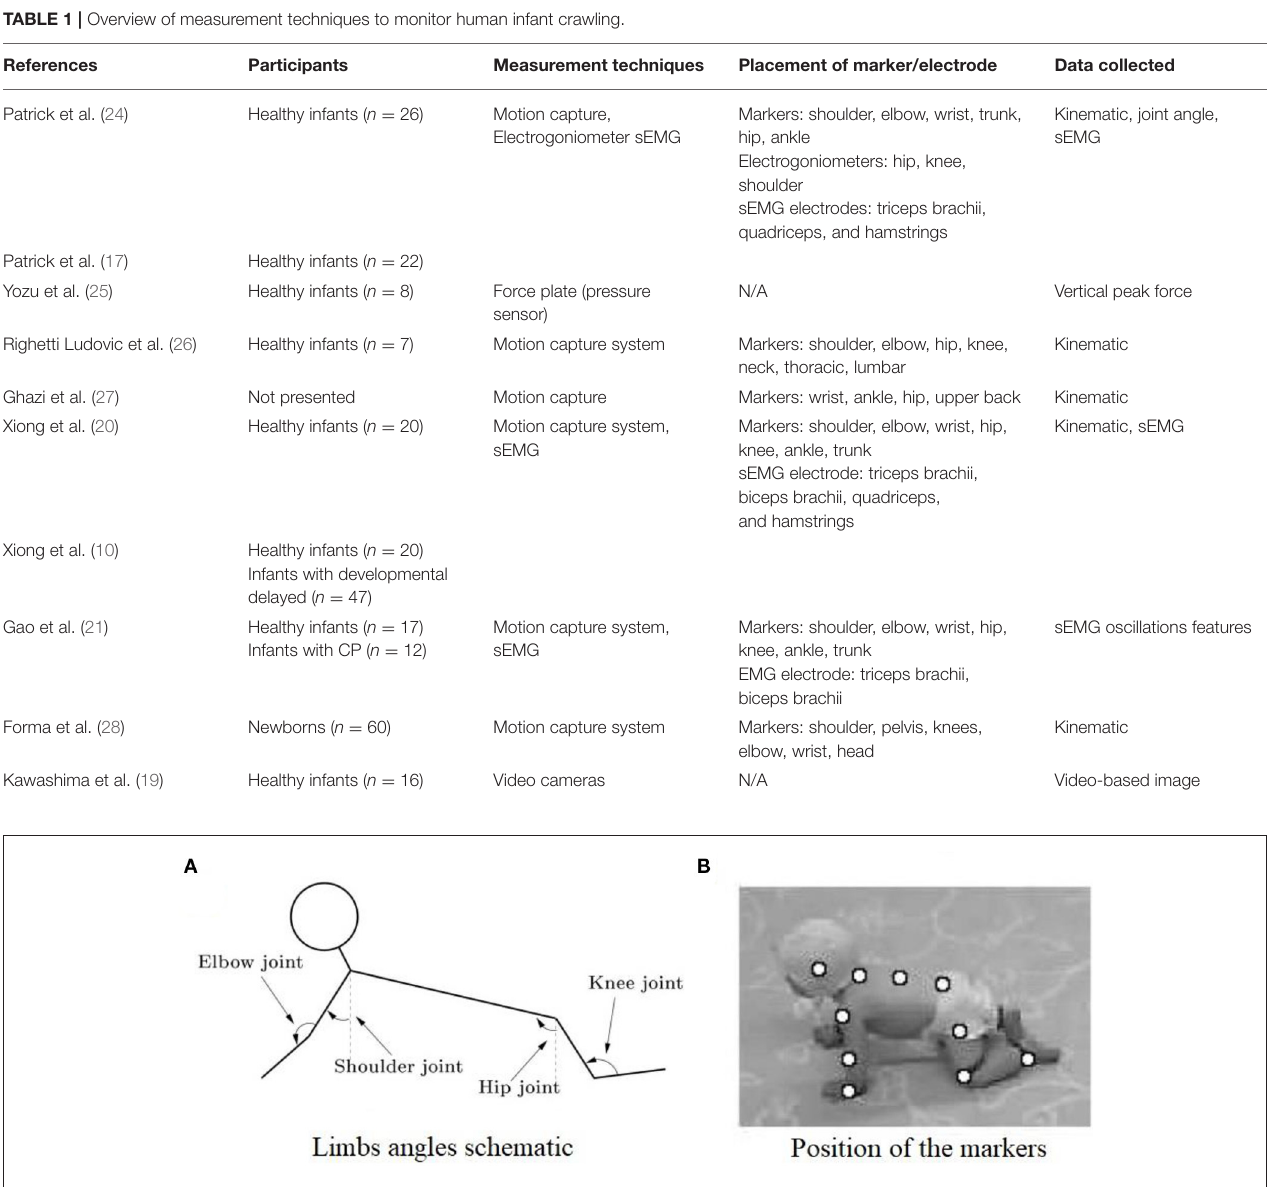
FIGURE 3 | (A) Illustration of the measured joint angles in sagittal plane. The shoulder, elbow, hip, and knee joints are measured. (B) Snapshot of a crawling infant together with the position of the markers that were used to calculate the different angles